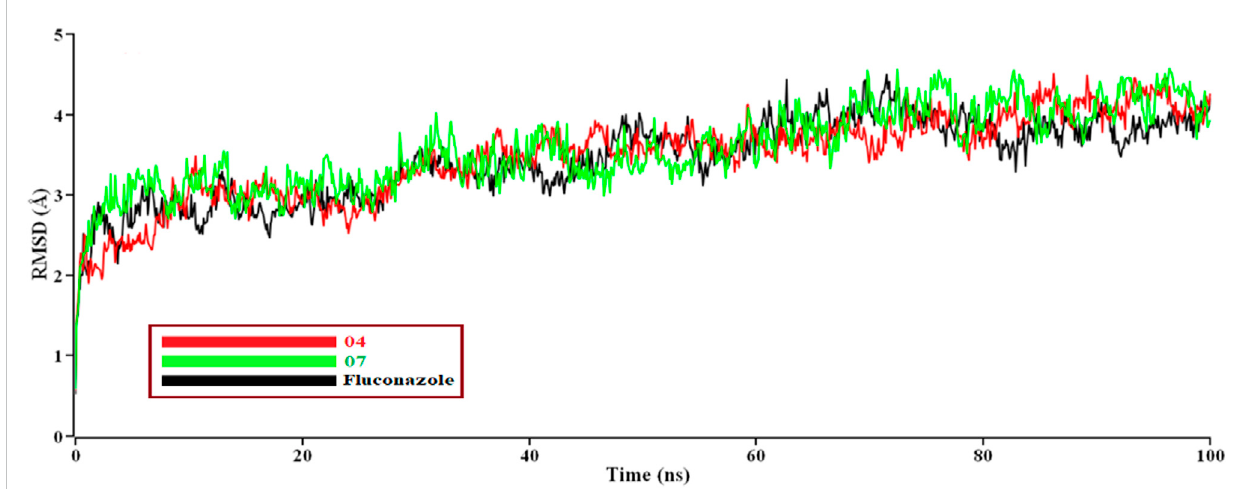
FIGURE 6 The time series of the RMSD of C α atoms for protein Mycobacterium smegmatis (PDB ID 7D6X) and ligand. Here, red and green lines denote the 04 and 07 complexes, and the black lines denote the subjected drug Fluconazole,